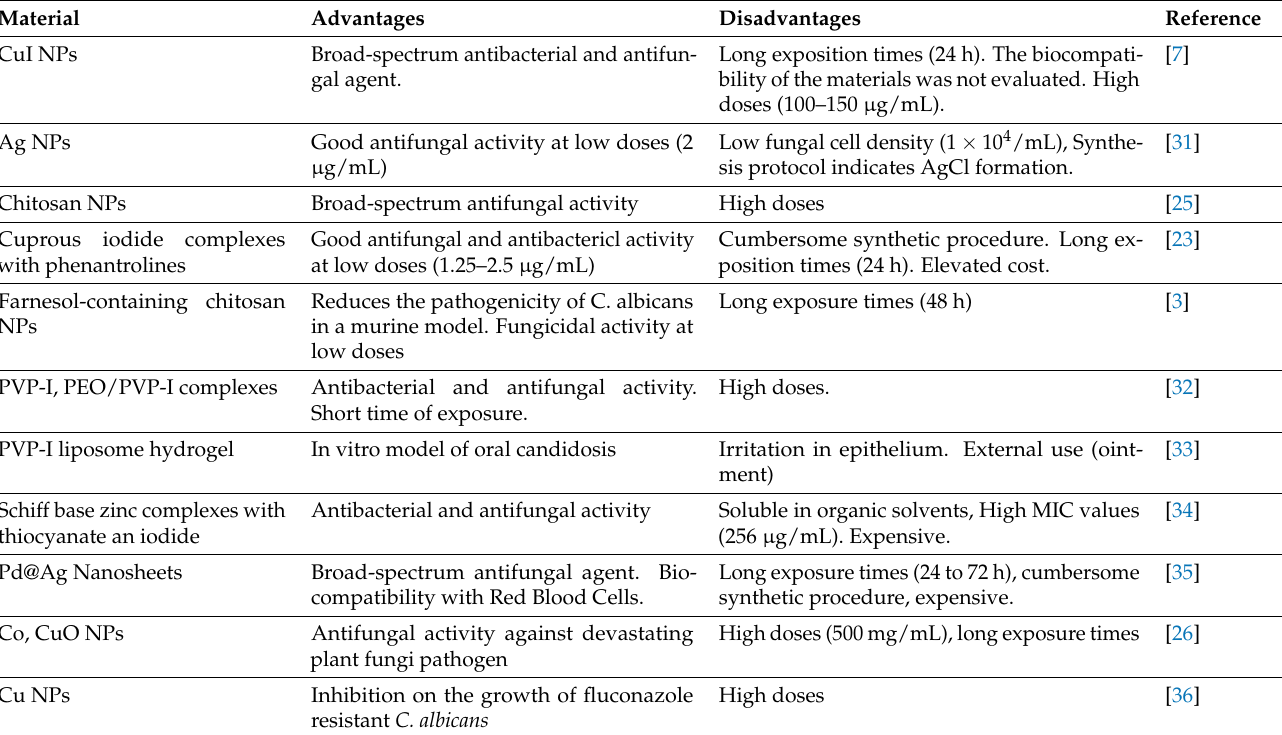
Table 3. Comparison of the properties of non-conventional antifungal